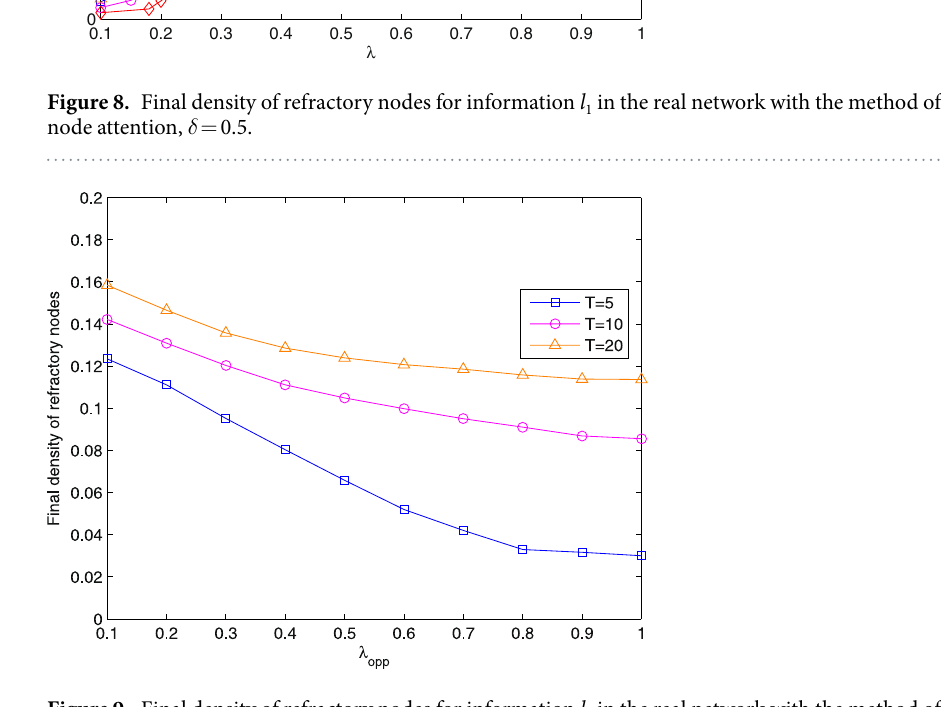
Figure 9. Final density of refractory nodes for information l 1 in the real network with the method of propagating opposite information, λ = 0.2, and δ =